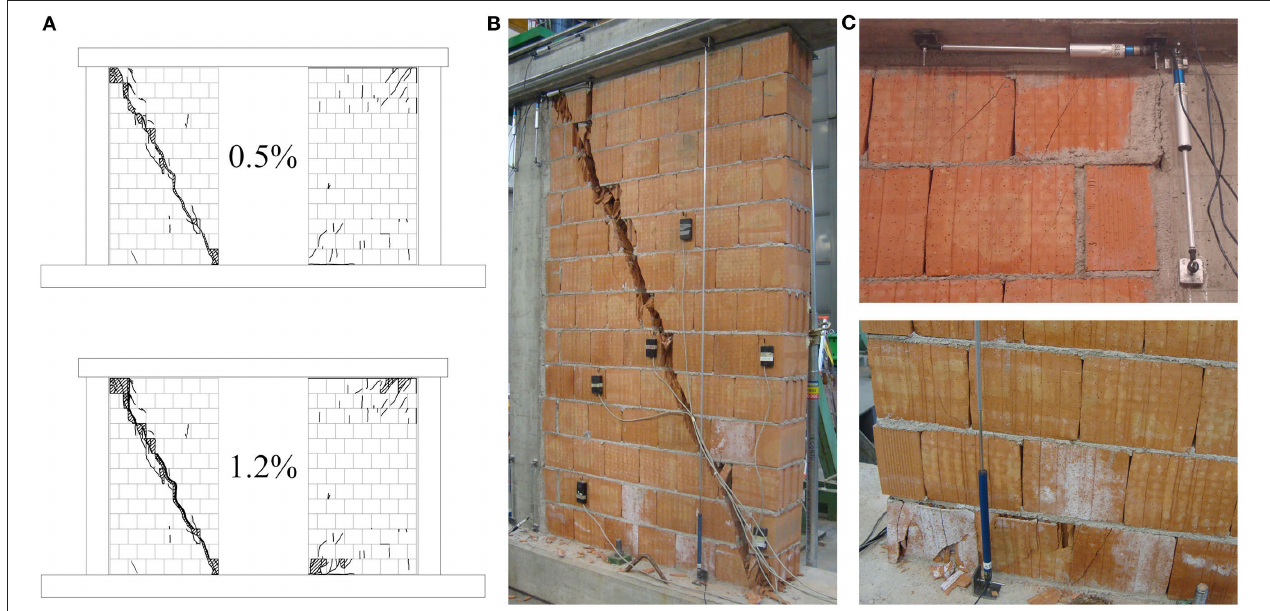
FIGURE 15 | 9-PRIU: damage pattern at 0.5 and 1.0% drift (A) ; damage on the vertically reinforced wall (B) ; slight damage and toe crushing of the horizontally reinforced wall (C)